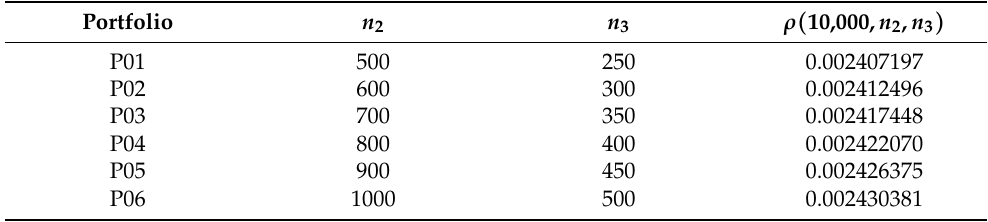
Table 4. Cases 1.3—Impact of the portfolio structure on the risk index.